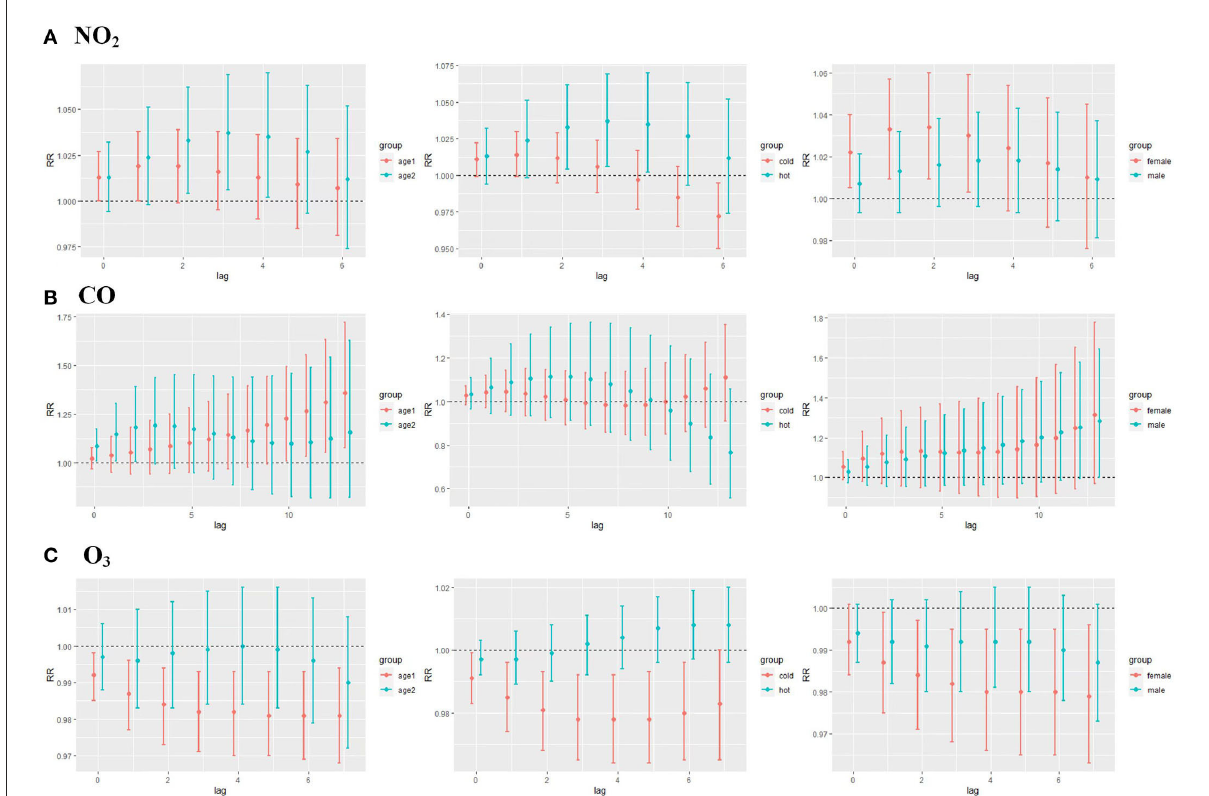
FIGURE6 (A) CHD lag-specific relative risks (95% CI) per 10 unit increase in the daily concentrations of NO 2 in models stratified by age, gender, and season; (B) CHD lag-specific relative risks (95% CI) per 1 unit increase in the daily concentrations of CO in models stratified by age, gender, and season; (C) CHD lag-specific relative risks (95% CI) per 10 unit increase in the daily concentrations of O 3 in models stratified by age, gender, and season (age1 refers to people ≥ 65 years of age and age2 refers to people < 65 years of age, cold season is from October to March, and the hot season is from April to